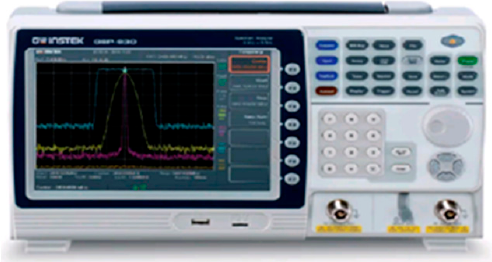
Figure 5. GSP-930 Spectrum Analyzer.